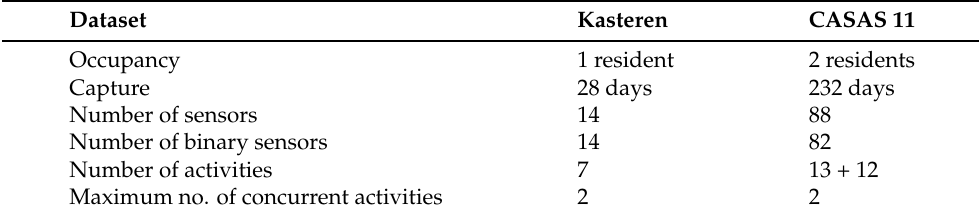
Table 2. Datasets used in experiments.